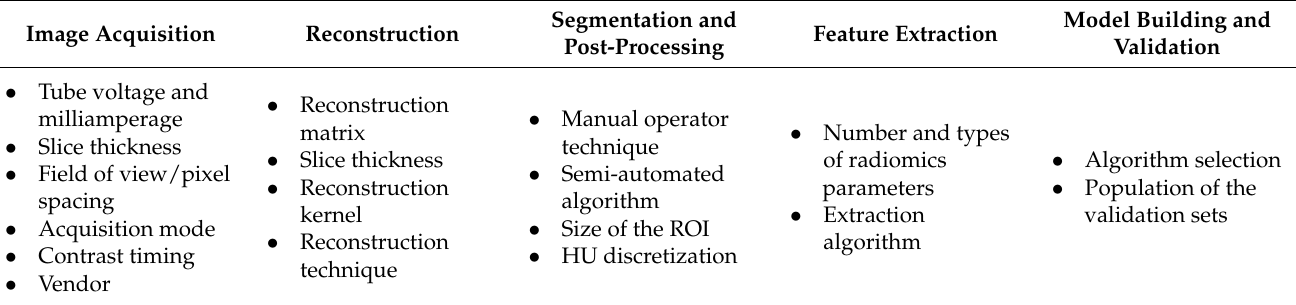
Table 3. Potential factors limiting radiomic feature robustness, reproducibility, and classification performance. Image Acquisition Reconstruction